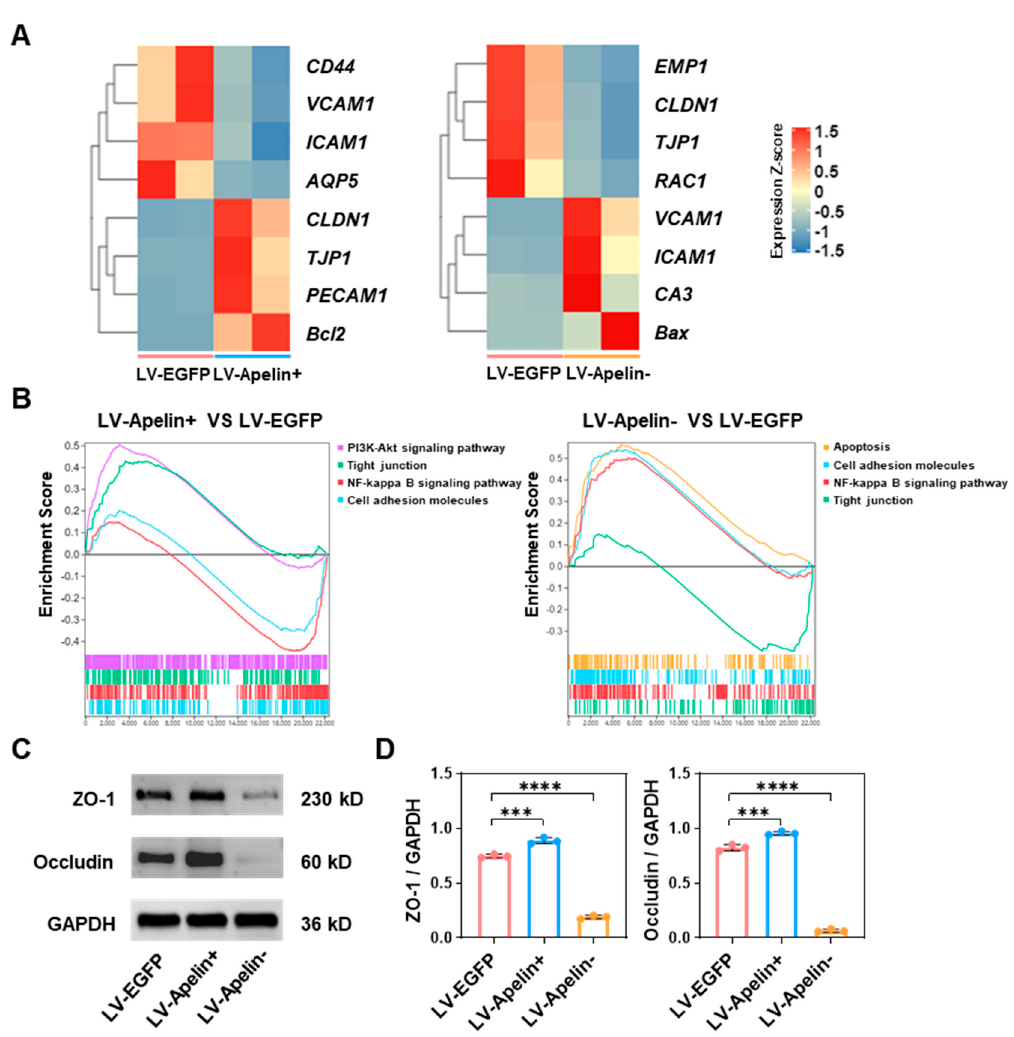
Figure 5. The mechanism underlying the protective role of apelin in the early stages of diabetic retinopathy. ( A ) The heatmap of differential gene expression showed that LV-Apelin+ upregulated genes related to tight junction, and anti-apoptosis downregulated genes related to the adhesion molecule and vascular permeability. In contrast, LV-Apelin − upregulated genes related to adhesion molecules and pericyte apoptosis, and downregulated genes related to tight junction genes (n = 2). ( B ) The results of GSEA were consistent with the differential gene expression analysis. ( C ) Representative Western blot images and ( D ) the quantification of the relative protein levels revealed that the levels of ZO-1 and occludin were increased by LV-Apelin+ but decreased by LV-Apelin − . The data were expressed as mean ± SD. LV-Apelin+ versus LV-EGFP; LV-Apelin − versus LV-EGFP; *** p < 0.001, **** p < 0.0001 (n = 3).